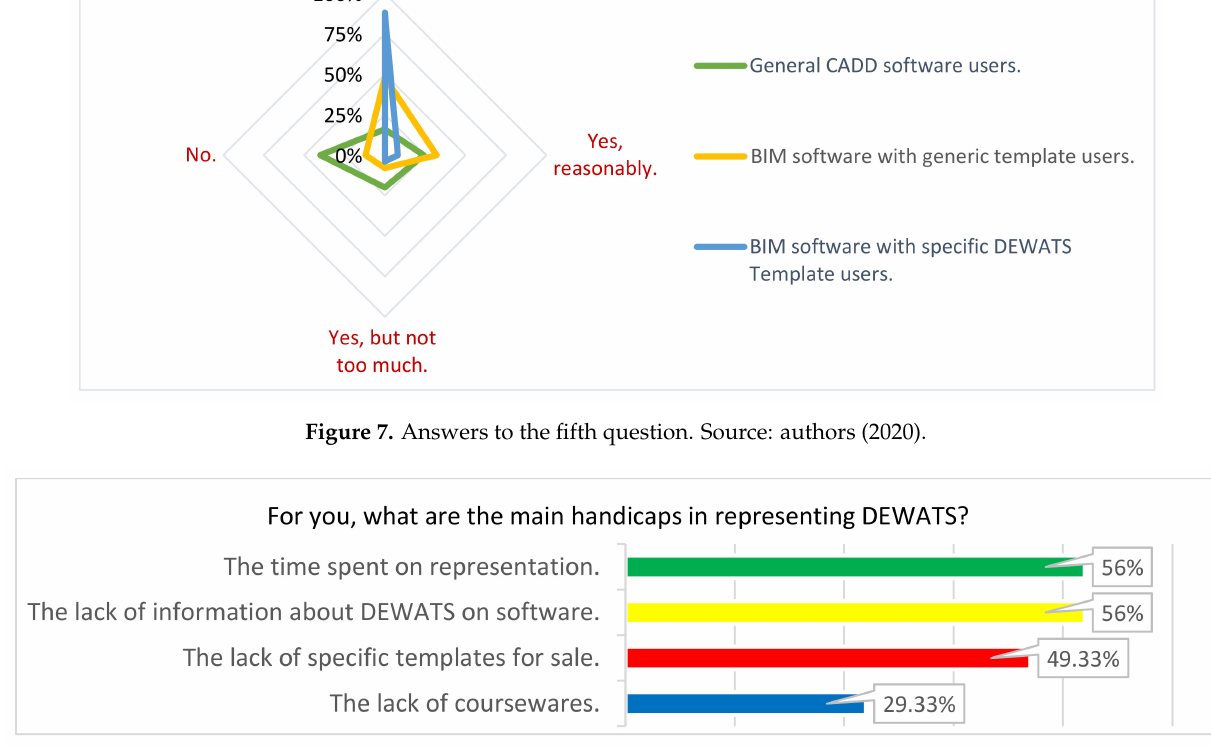
Figure 8. Answers to the sixth question. Source: authors